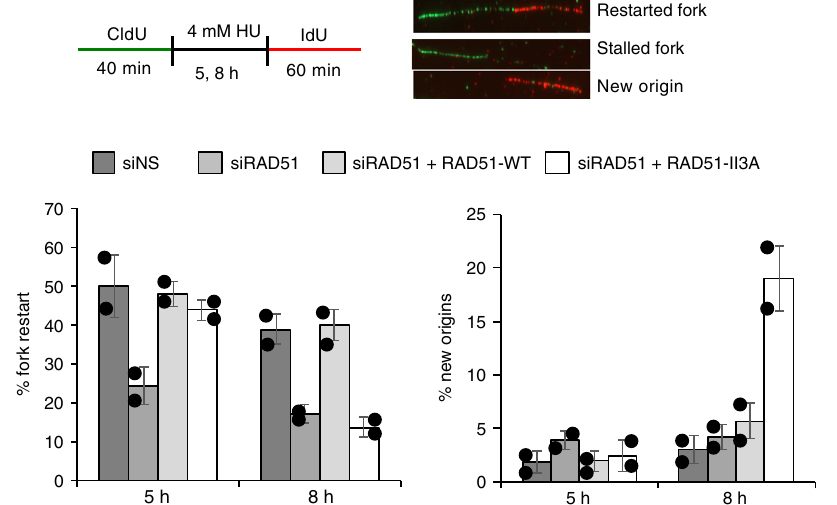
Fig. 4 Replication restart defects in hsRAD51-II3A expressing cells after treatment with HU. Graphs depict the percentage of replication forks that restart after the indicated treatments (left) or the percentage of new origin fi rings (right). Graph is average of two independent experiments consisting of at least 100 replication tracts with error bars representing standard deviation. Values are presented as mean ± SD. Statistical signi fi cance was determine using a t test. Schematic of experimental design is above the graphs and fi bers that represent restarted forks (CldU + IdU), stalled fork (CldU only) and new origin (IdU only) are shown. Source data are provided as a source data fi